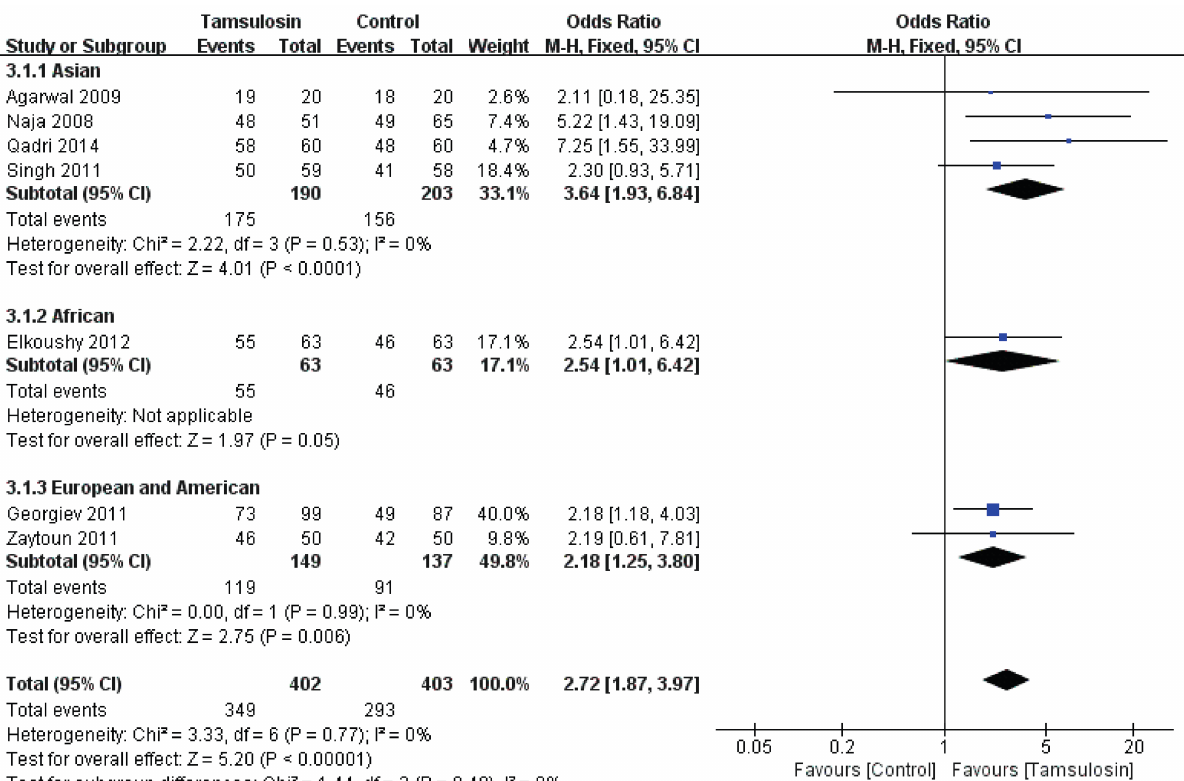
Figure 3 - Forest plots with stone clearance as the outcome according to geographic regions.